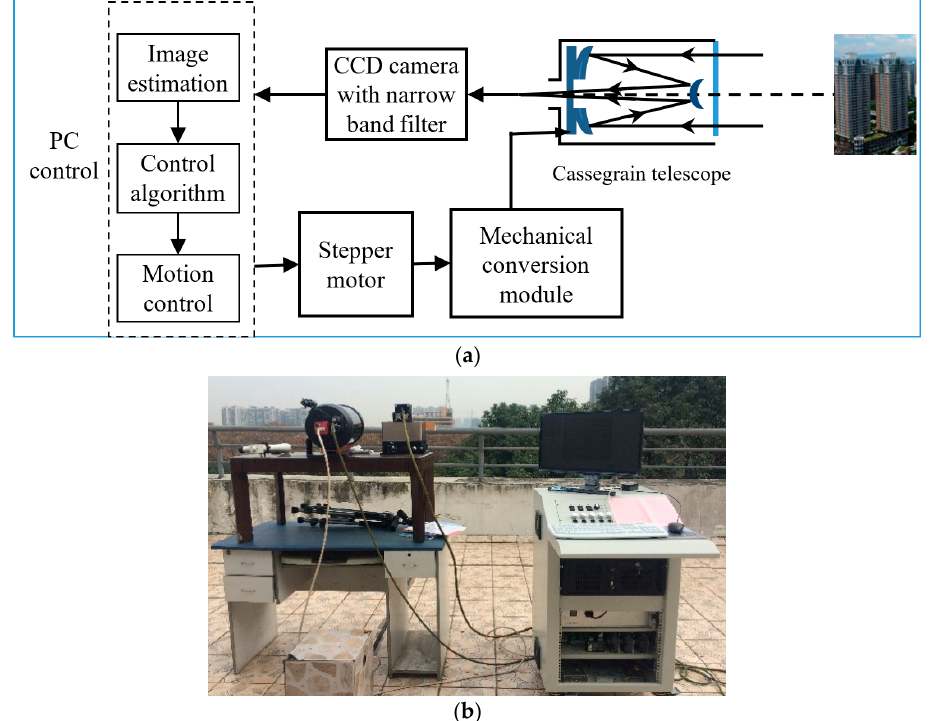
Figure 1. ( a ) Auto-focus diagram of a Cassegrain telescope system; ( b ) Hardware experiment system.